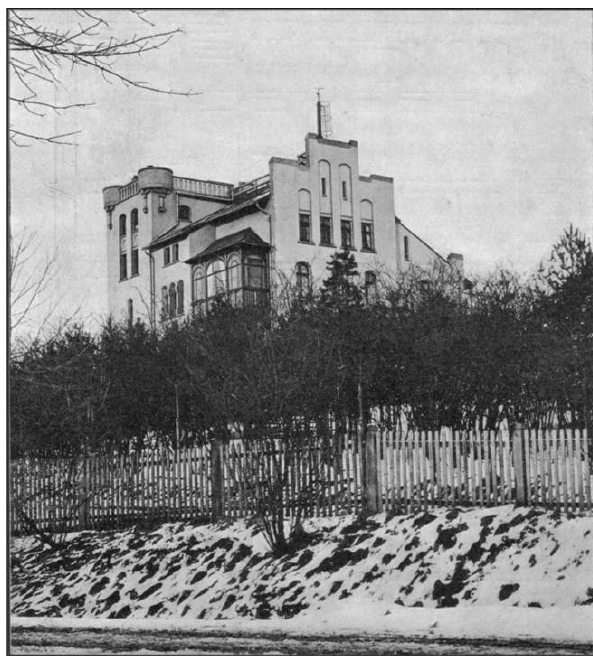
Figure 2. The Institute of Geophysics circa 1905. Undated picture taken and slightly modified from Wiechert (1906).